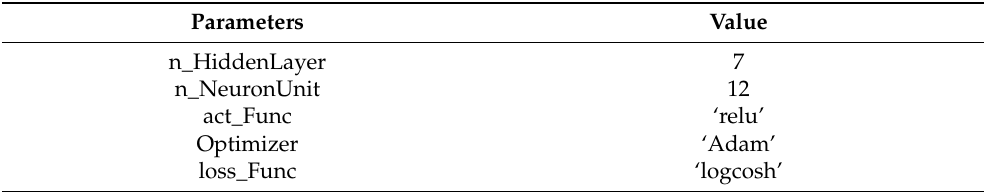
Table 7. the optimized hyper-parameters